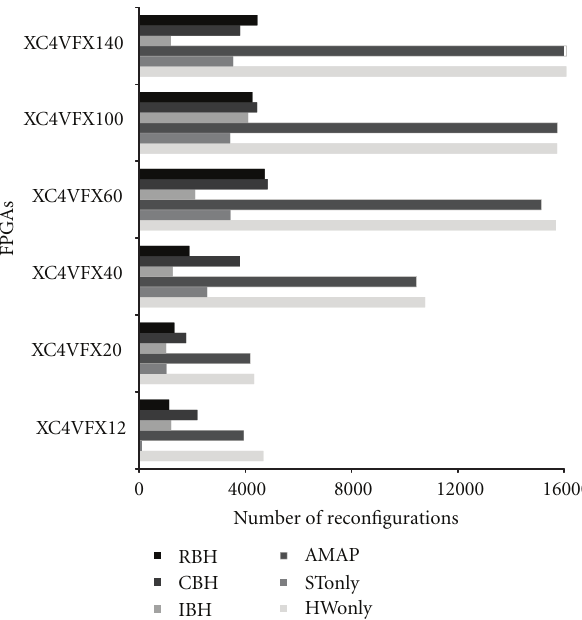
Figure 6: Heuristics comparison under di ff erent FPGAs conditions in terms of number of reconfigurations. There is a direct relation between the number of reconfigurations and the FPGA